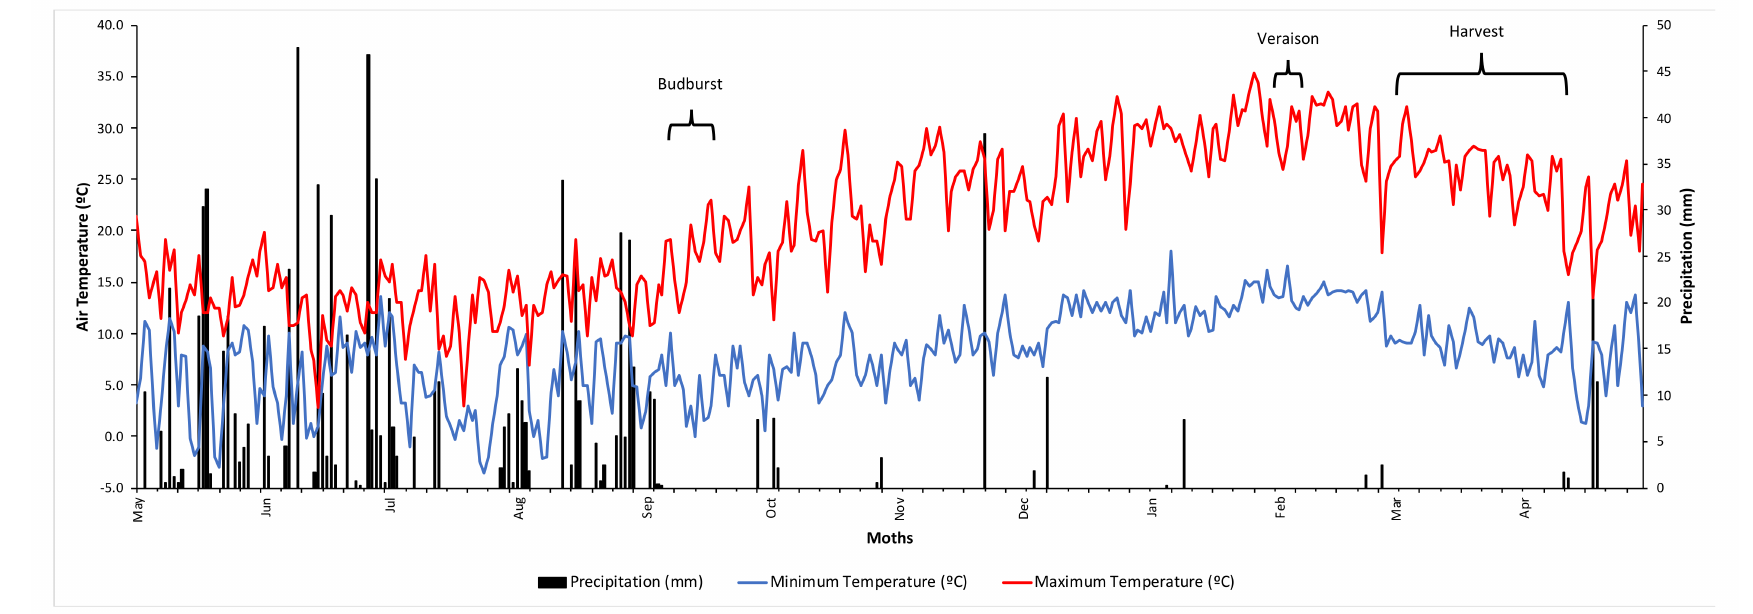
Figure 1. Precipitation (mm), and minimum and maximum temperature ( ◦ C) during the 2005–2006 season. Budburst, veraison, and harvest show the periods of occurrence of the main phenological stages for the four cultivars under